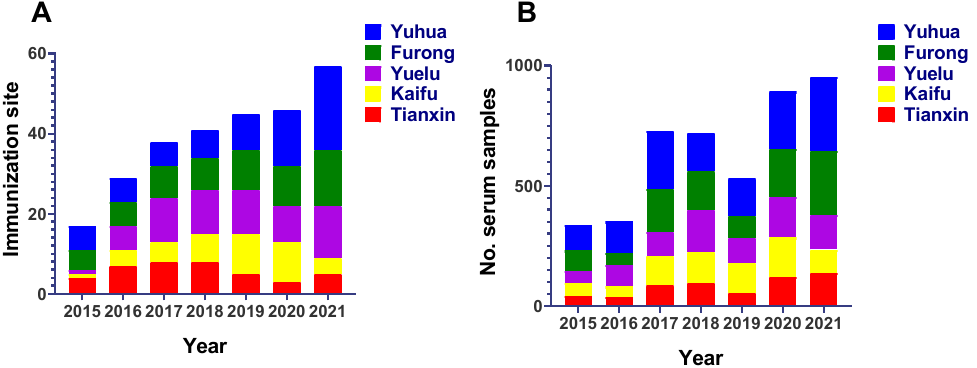
Figure 2. The number of immunization sites (pet hospitals) involved in the study ( A ) and the num ‐ ber of dog sea collected for rabies antibody testing ( B ) in Changsha, China, 2015–2021.